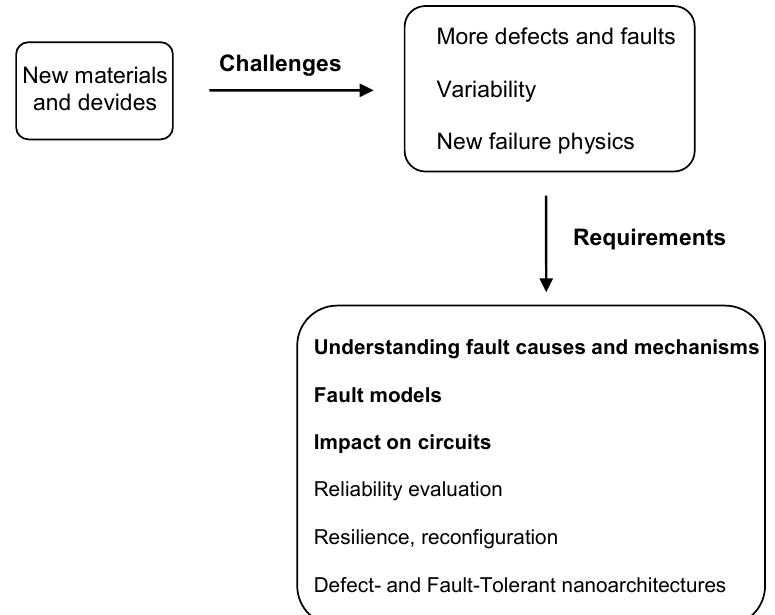
Figure 4. Reliability challenges and requirements of emerging nanodevices and nanoarchitectures.